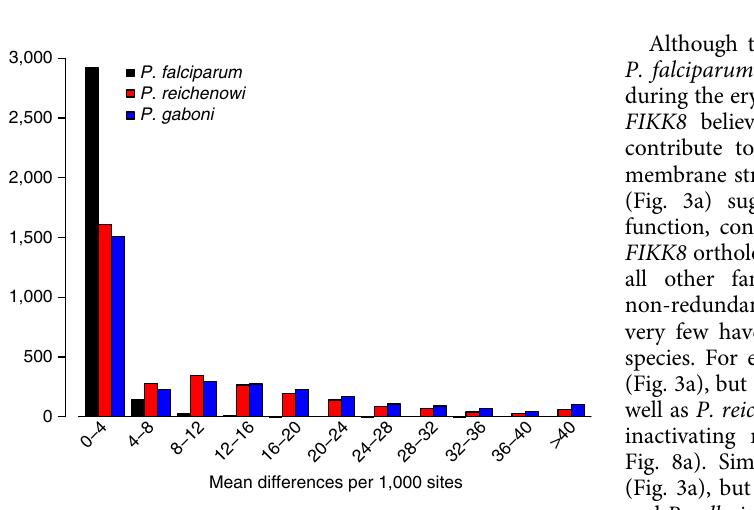
Figure 2 | Sequence diversity within three Laverania species. The average pairwise nucleotide sequence diversity is shown for 3,111 orthologous core genes at fourfold degenerate sites for 12 geographically diverse strains of P. falciparum (black), two strains of P. reichenowi (red) and two strains of P. gaboni (blue). For P. falciparum field isolates, diversity information was obtained from SNP data (only data sets representing single-parasite strains were used for analysis; see the ‘Methods’ section for